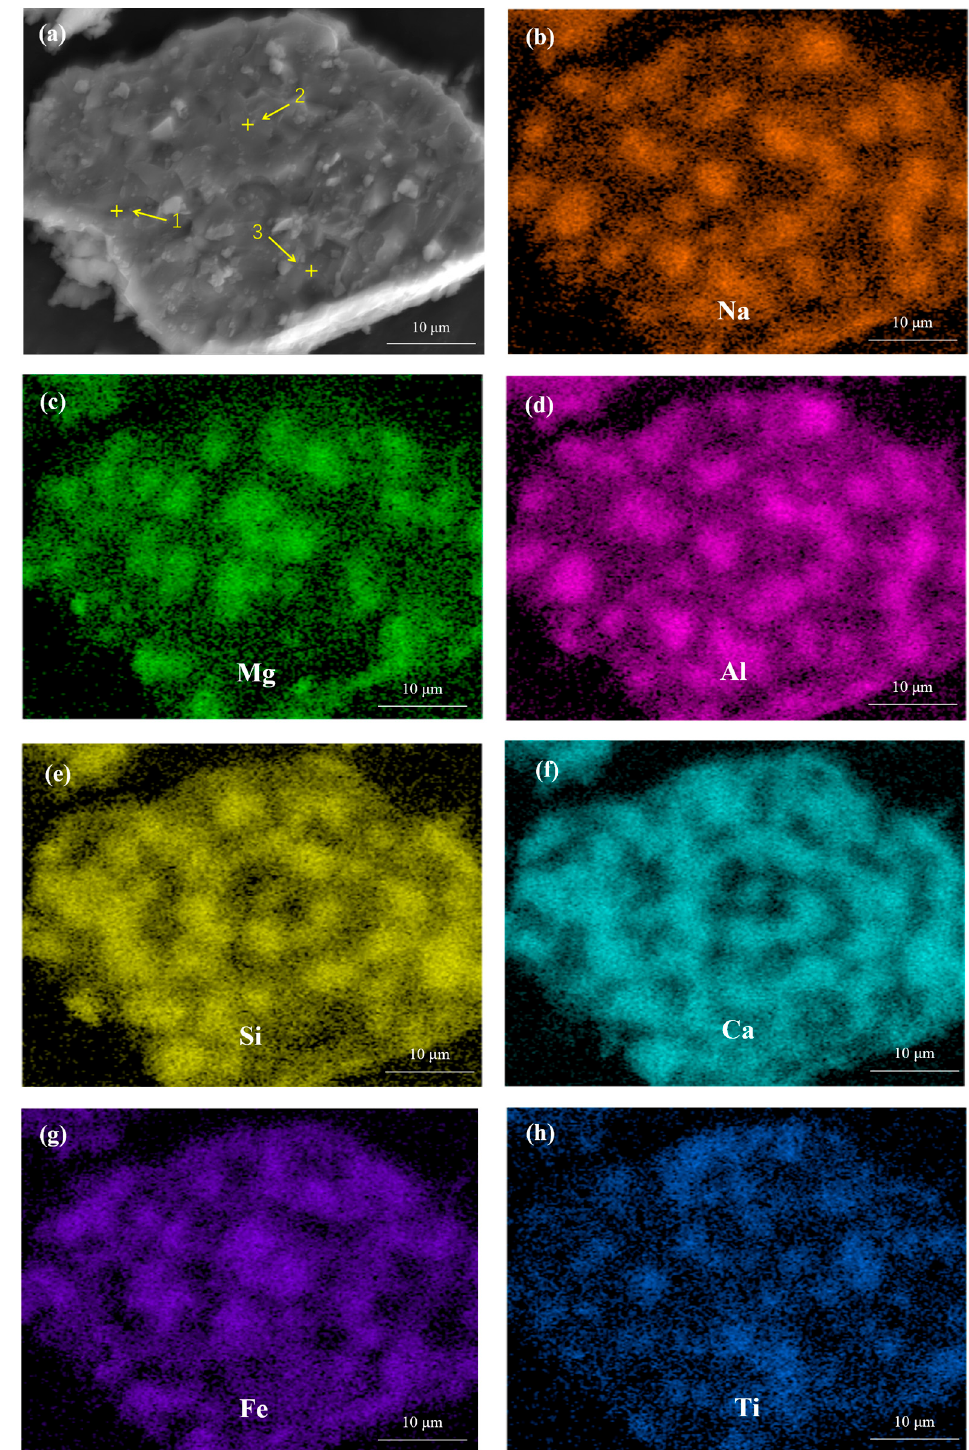
Figure 13. SEM images of the sintered red mud ( a , b ); leaching red mud ( c , d ); and magnetic separa- tion product( e , f ) with magni fi cations from 500× to 5k×; The yellow numbers (4–9) in the sub fi gures ( d , f ) corresponding to the EDS results in the Table 4.